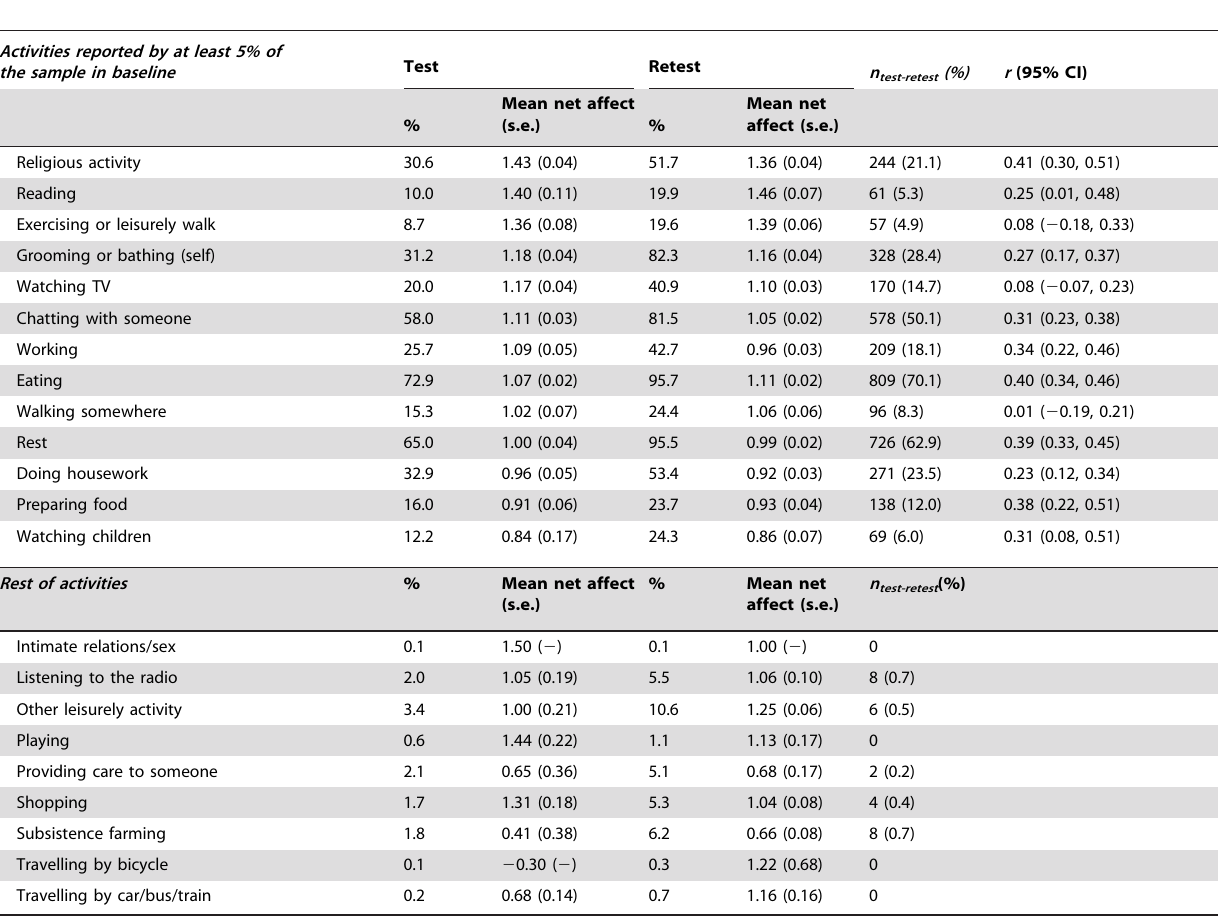
Table 4. Activities coded in the baseline DRM ranked from the highest to the lowest weighted-duration mean net affect.